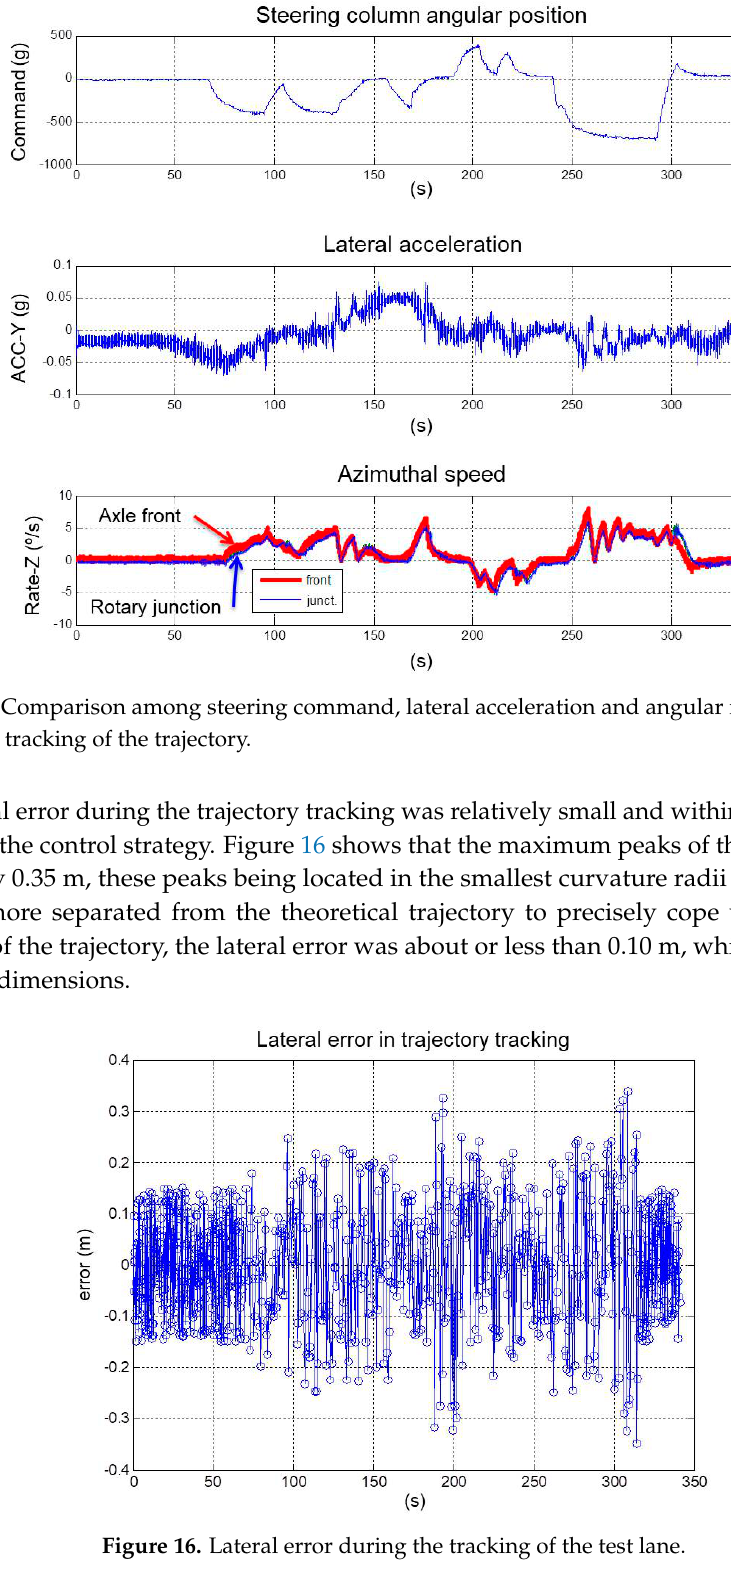
15 of 21 Figure 14. Comparison among bus speed, brake position and x-acceleration during the tracking trajectory. Brake control is applied 25 s after the start and from the times 125 to 300 s to cope with a downslope in the circuit. Figure 15 shows the experimental results obtained by applying the lateral control of the bus for tracking the required trajectory. This figure shows the steering command, the lateral acceleration of the bus and the angular rate on the Z-axis (azimuth). The angular rate sensor follows the curves of the trajectory commanded by the bus steering. The azimuthal speeds have been measured at two different points; the first, on the bus front axle, and the second, on the rotatory junction of the bus, in